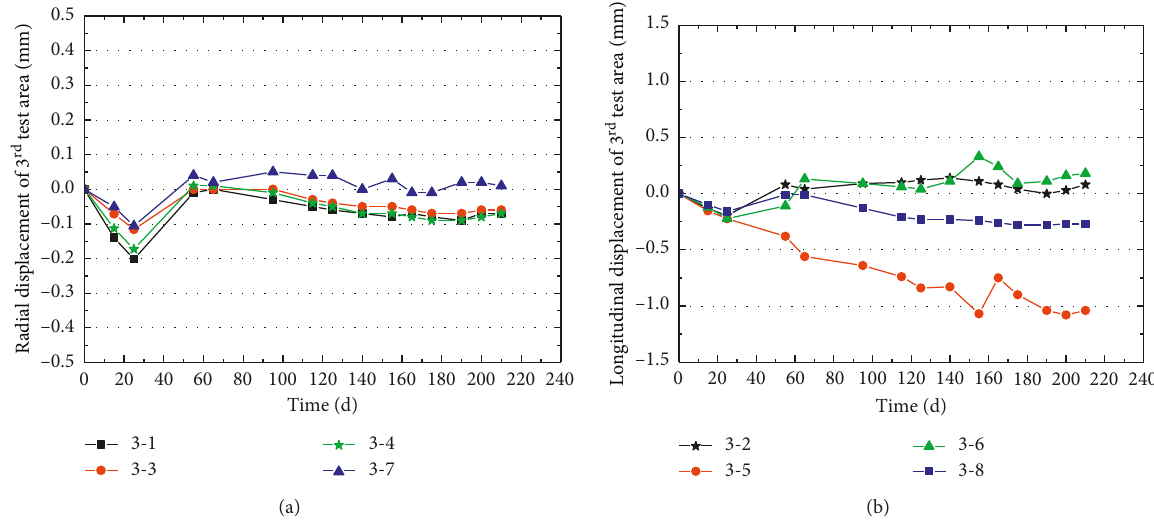
Figure 12: Radial and longitudinal displacement curves at the third test area ( − 700 m). (a) Radial displacement; (b) longitudinal